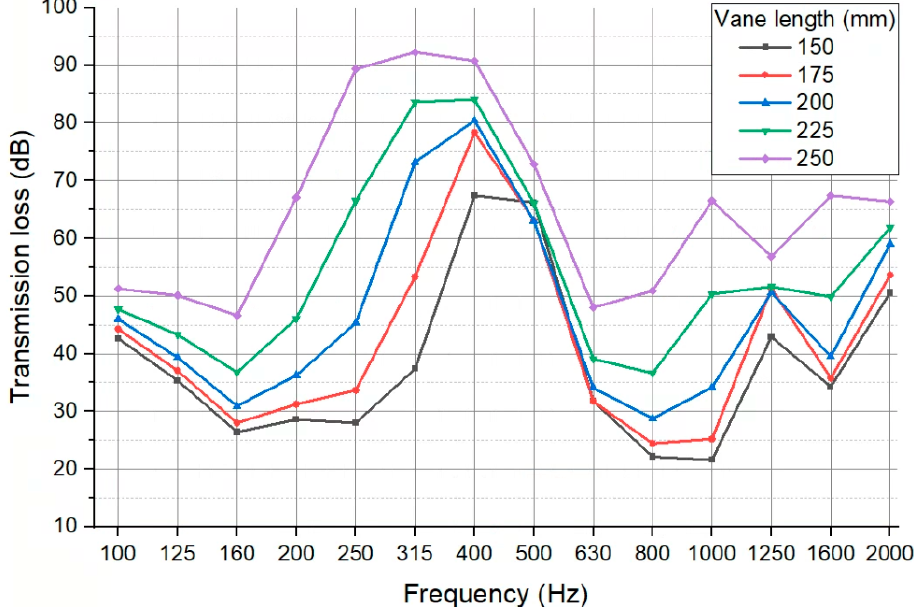
Figure 20. Transmission loss according to the vane length in the outer vane reverse type.